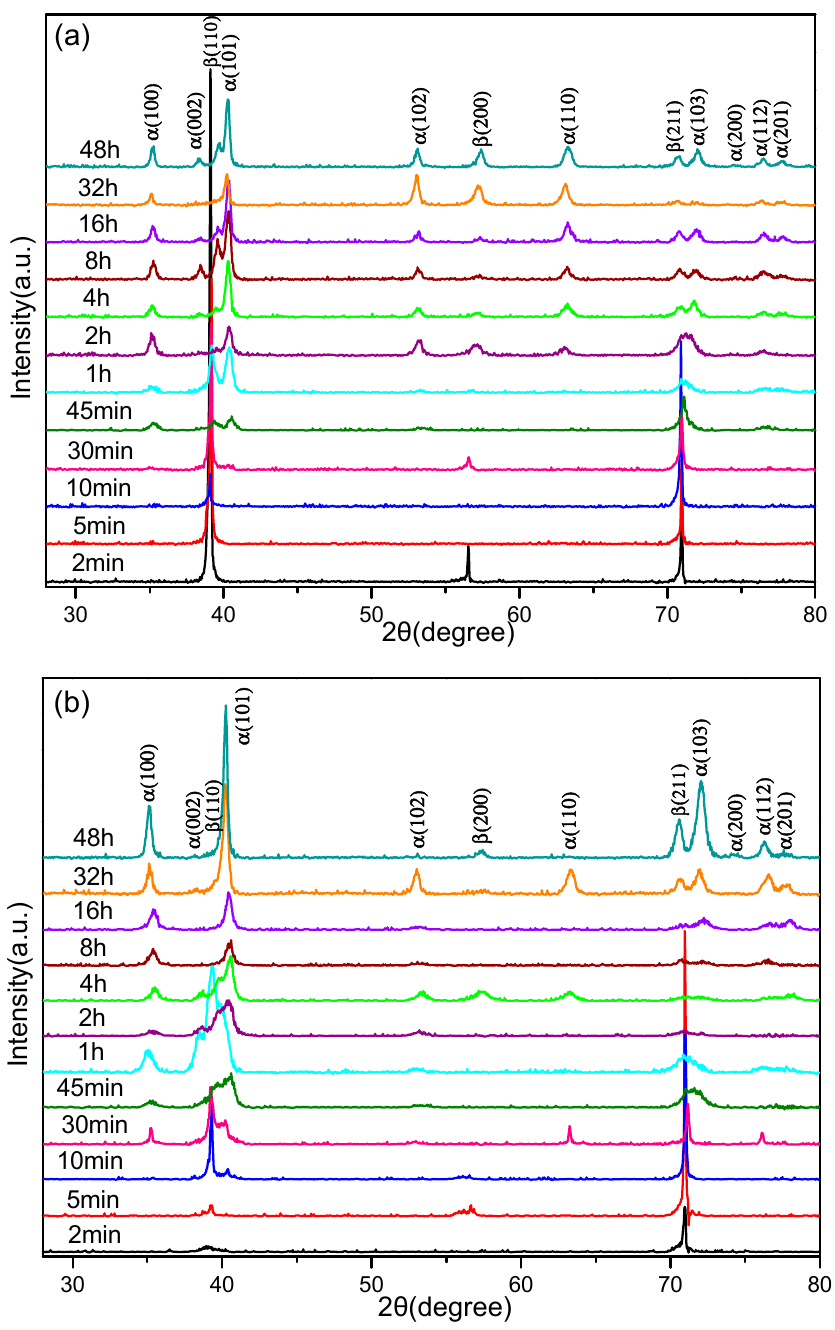
Figure 4. XRD patterns of the Ti–3.5Al–5Mo–4V alloy isothermally aged at 500 °C for different times after being solution-treated at ( a ) 850 °C and ( b ) 1050 °C.